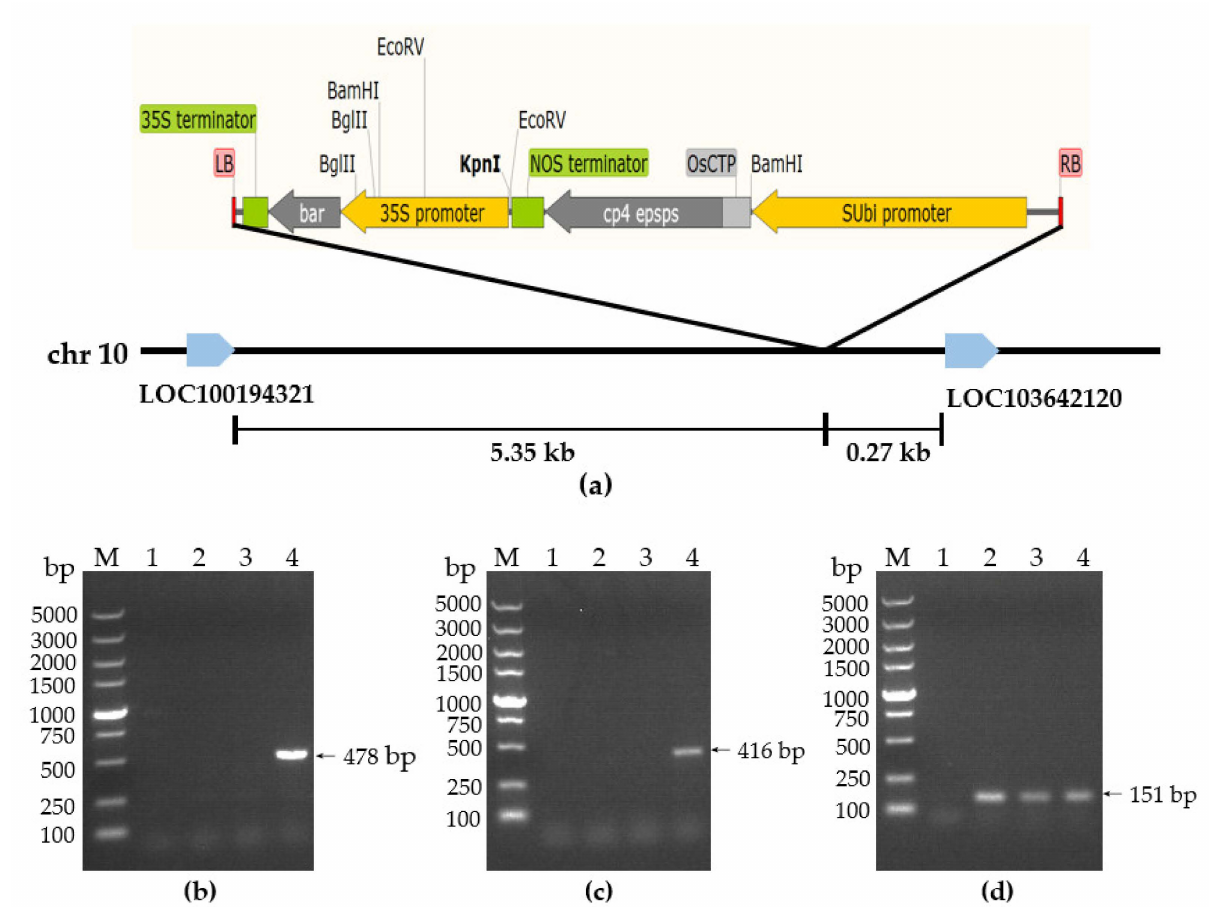
Figure 3. T-DNA integration site and event-specific PCR analysis. ( a ) The integration features of T-DNA in SCB-29. ( b ) PCR amplification using the primer pair LB-MG/LB-TDNA. ( c ) PCR amplification using the primer pair RB-TDNA and RB-MG. ( d ) PCR amplification of the reference gene zSSIIb . M, DL 5000 DNA Marker. 1, double distilled H 2 O. 2, non-transgenic maize. 3, DNA mixture of transgenic maize (Ruifeng125, Zheda Ruifeng 8 and nCX-1). 4,